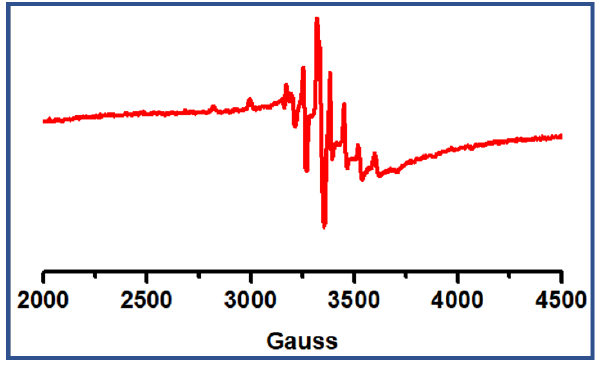
Figure 22. X-band EPR spectrum of reused complex [V IV O(acac)L 1 ]@PS ( 3 ) recorded in DMSO at 100 K (for spin Hamiltonian parameters, see text).